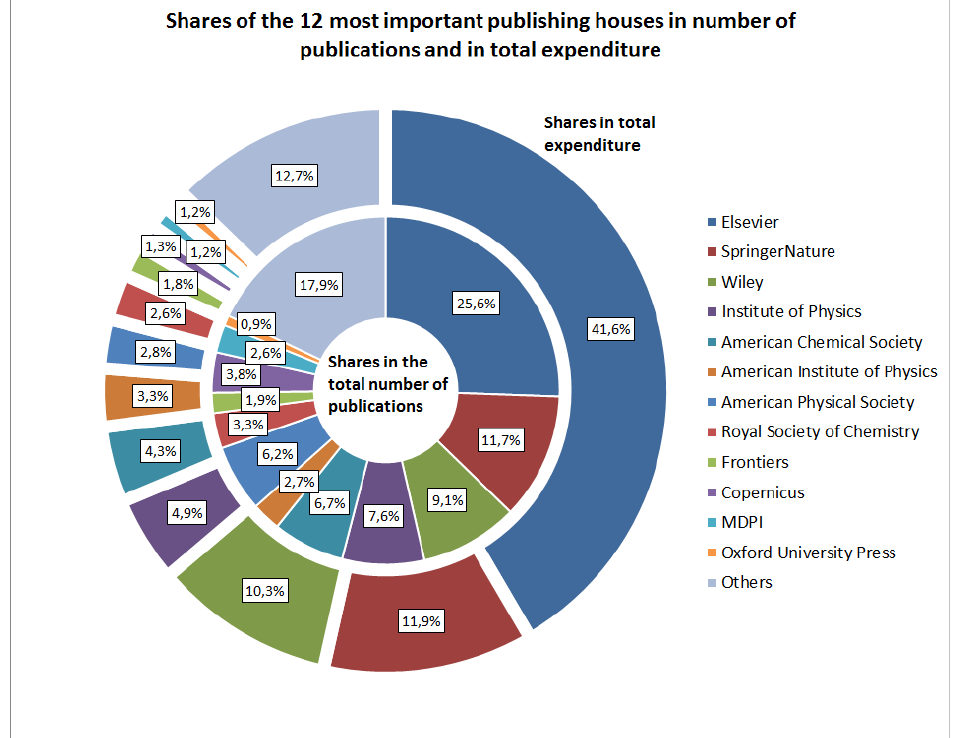
Figure 1. Shares in the total number of publications and in total expenditure in 2017. Source: Forschungszentrum